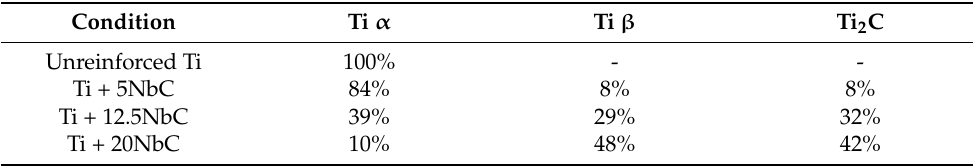
Table 1. The phase composition (vol.%) of the hot-pressed samples.